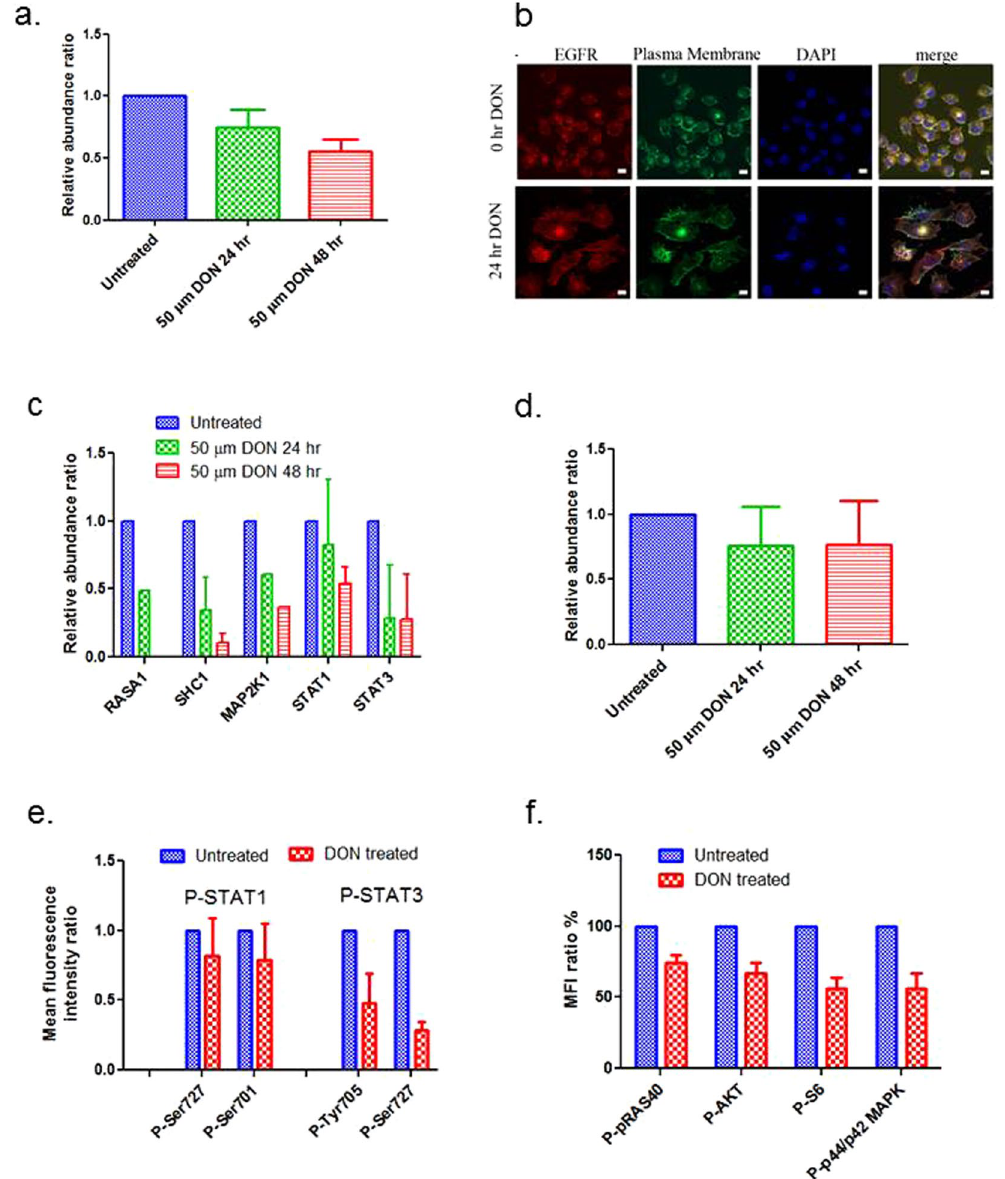
Figure 4. DON treatment influenced the expression and localization of EGFR associated signaling proteins. ( a ) The abundance changes of EGFR in GEM-R MiaPaCa cells before and after treatment with 50 µ m of DON (proteomics data). ( b ) Immunofluorescence (IF) images of EGFR in GEM-R MiaPaCa cells before and after DON treatment. red - EGFR, green – plasma membrane, blue - DAPI. ( c ) Abundant changes of the proteins associated with EGFR signaling in MiaPaCa cells before and after DON treatment (proteomics data). ( d ) Expression changes of AKT proteins before and after DON treatment (proteomics data). ( e ) Changes in phospho-STAT1 and phospho-STAT3 before and after DON treatment (50 µ m of DON, 24 hr) (multiplex bead based analysis). Two different phosphorylation sites (amino acids are indicated) were measured for each protein. ( f ) Percentage mean fluorescent intensity ratios for phospho-pRas40, phospho-Akt, phospho-S6, and phospho-p44/p42 MAPK for untreated cells (blue) and DON treated cells (red) (multiplex bead based analysis). The error bars represent